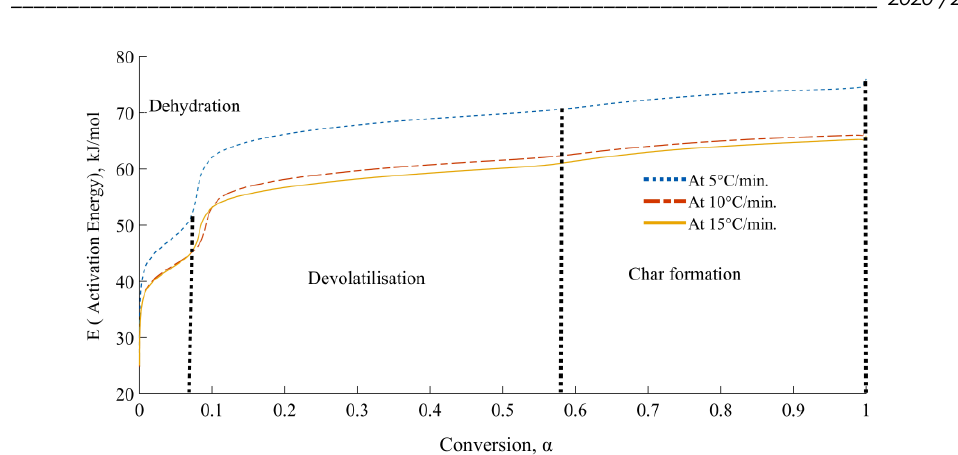
Fig. 4. Energy distribution at different stages of decomposition of pine